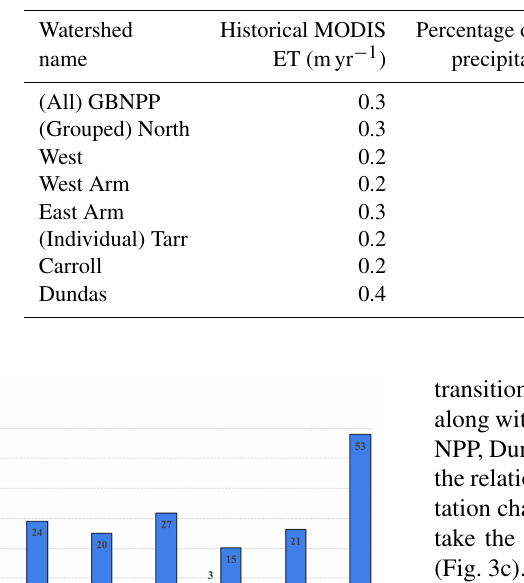
Figure 7. Runoff climatologies. (a) The domain-averaged and domain-aggregated historical (1979–2015) GBNPP runoff climatology parti- tioned into the constituents of snowmelt, ice melt, and rain runoff. The historical (2001–2014) MODIS-based evapotranspiration estimates are included on the historical plots, but the amounts are not subtracted from the modeled runoff climatology because they were derived separately from the modeling process. (b) The domain-averaged and domain-aggregated GBNPP projection scenario (RCP 8.5 scenario; 2070–2099) runoff climatology. Appendix B contains the historical and projection scenario runoff climatologies for each of the eight grouped and indi- vidual watersheds in the study area. For all figures, uncertainties are not shown to facilitate readability. Table 4. Estimated historical (2002–2014) and evapotranspiration (ET) in myr − 1 for all watersheds.